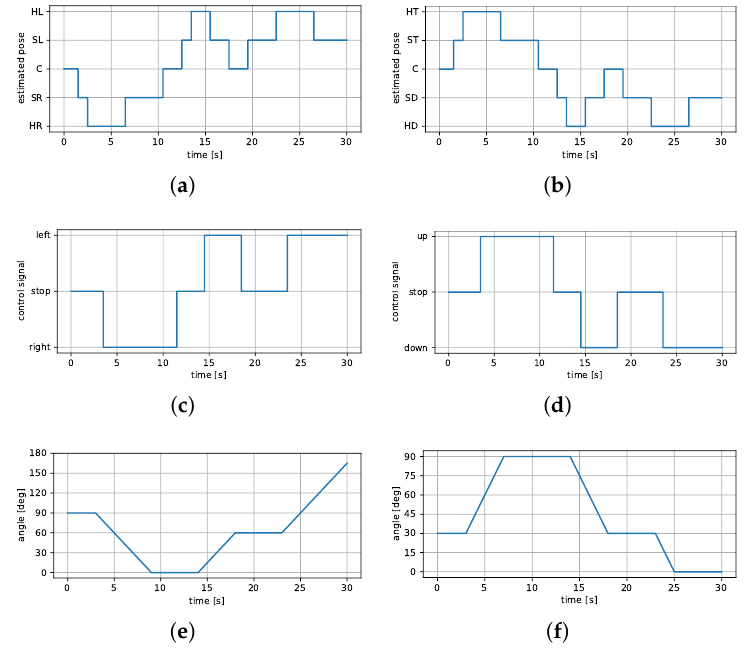
Figure 9. Estimated head orientation, corresponding control signals, and the resulting angle change of the CCTV camera. The left column represents the movement in the horizontal direction, whereas the second—vertical. ( a ) Estimated orientation (horizontal). ( b ) Estimated orientation (vertical). ( c ) Control signals (horizontal). ( d ) Control signals (vertical). ( e ) Servomechanism angle (horizontal). ( f ) Servomechanism angle (vertical).